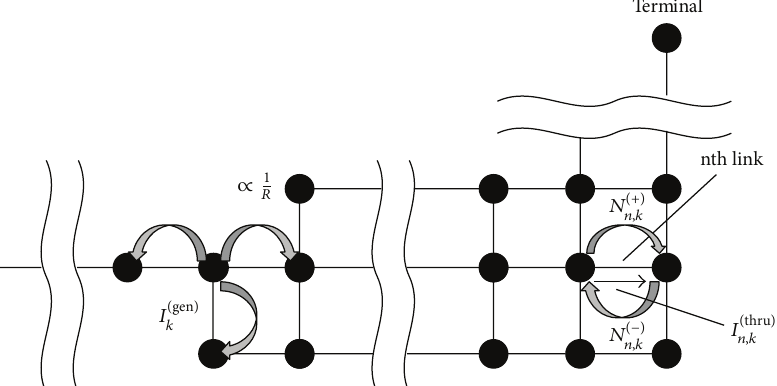
( gen ) 𝑘 by random-walk